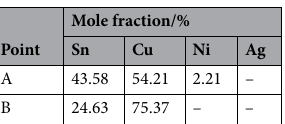
Table 1. EDS analysis results of solder joint interface shown in Fig.